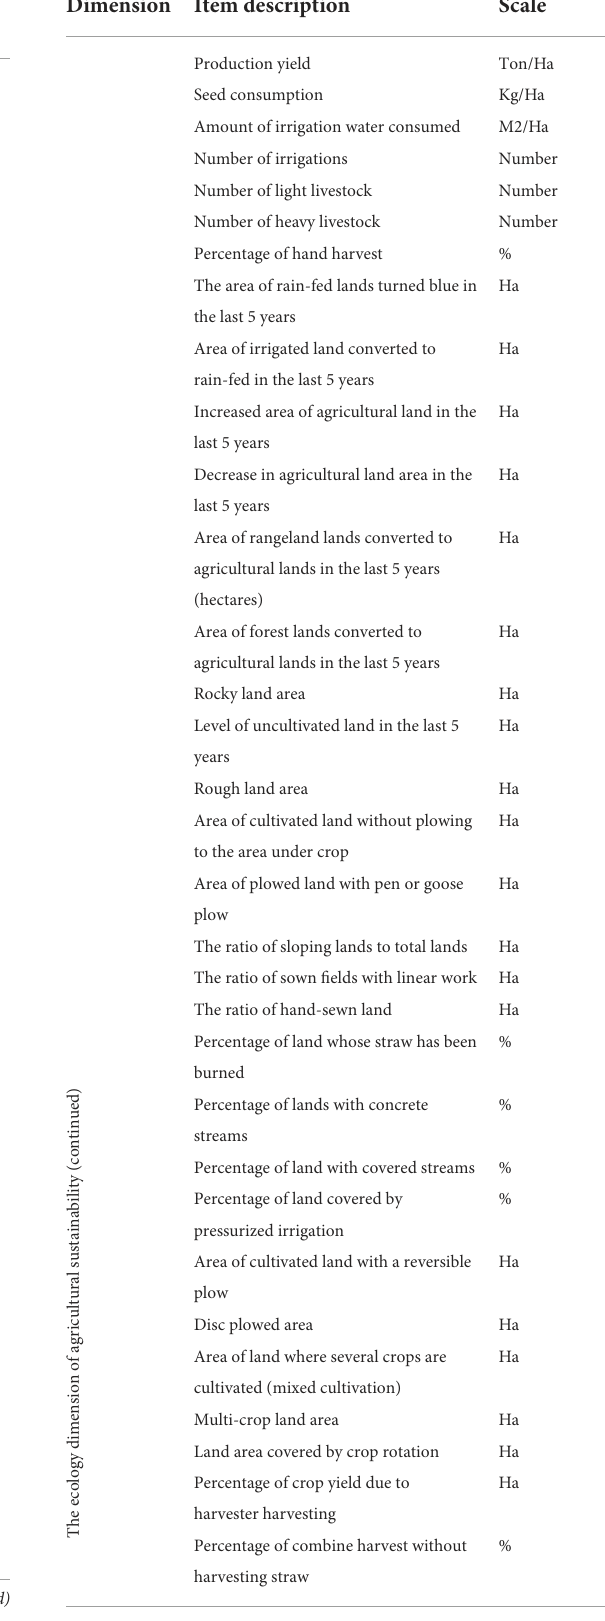
TABLE 1 Item description of different dimensions of agricultural